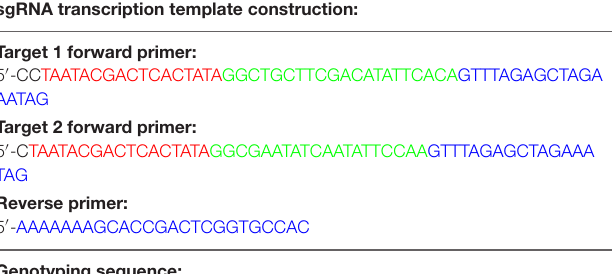
TABLE 1 | The primers used in KO mouse generation. sgRNA transcription template